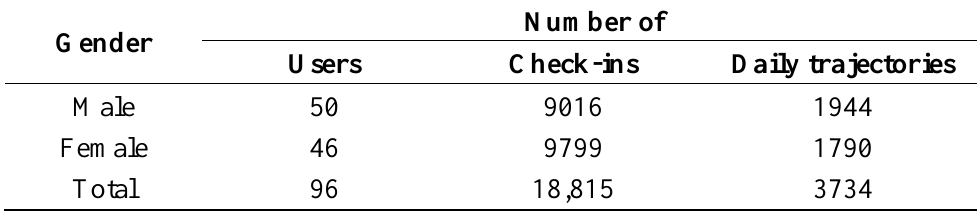
Table 1. Description of the empirical data set used in this